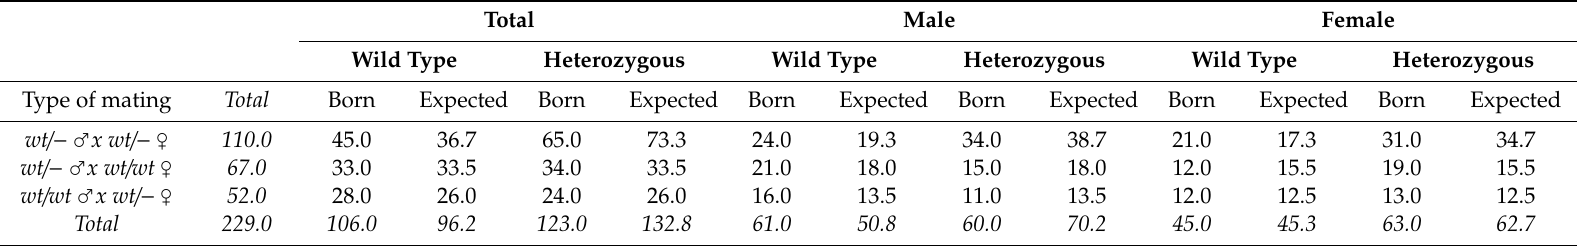
Table 2. Distribution of o ff spring in di ff erent type of mating according to Lonp1 genotype. − indicates targeted Lonp1 allele. Total Male Female Wild Type Heterozygous Wild Type Heterozygous Wild Type